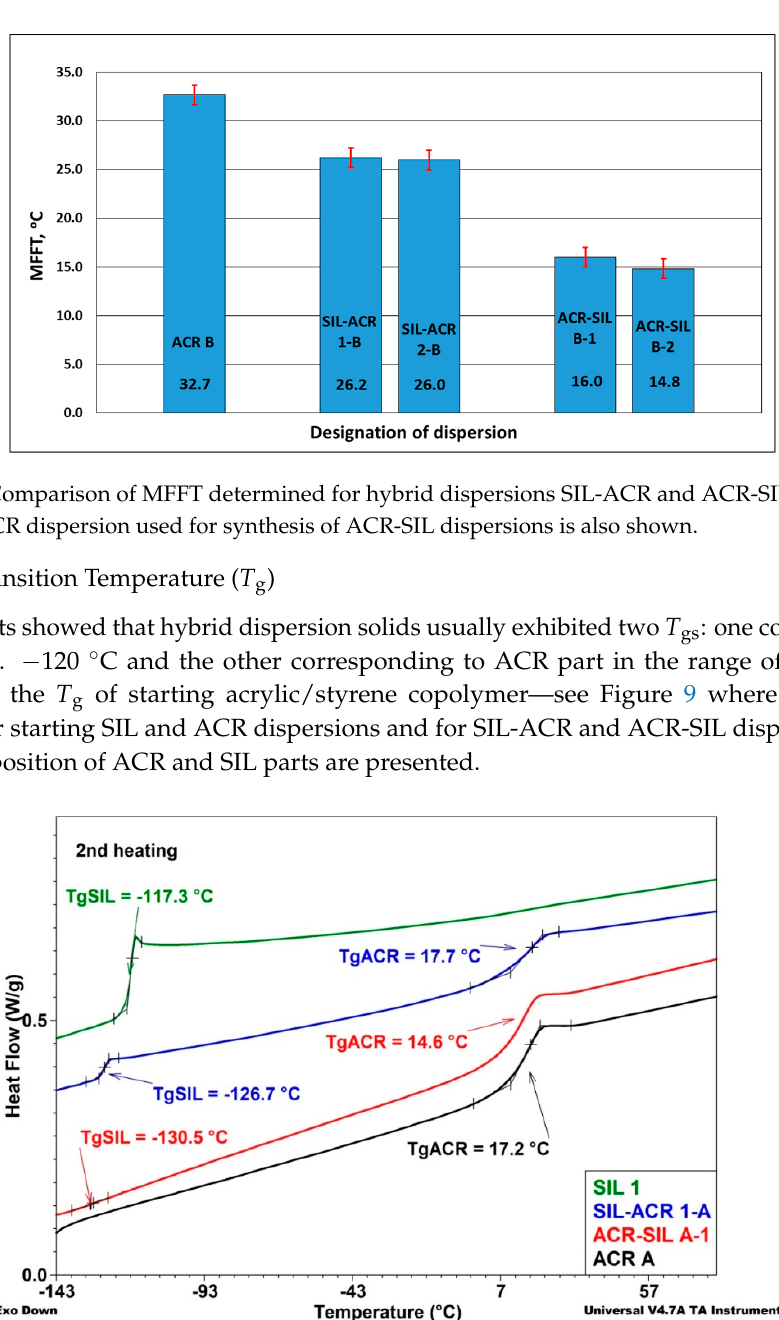
( c ) Figure 7. Structure of hybrid dispersion particles settled on the micromesh net as determined by transmission electron microscopy (TEM): ( a ) SIL-ACR dispersion, higher magnification, ( b ) SIL-ACR dispersion, lower magnification, ( c ) ACR-SIL dispersion, higher magnification. Lighter shade represents silicone resin and darker shade–acrylic/styrene copolymer. Lack of formation of core-shell ACR-SIL hybrid particles in the course of polymerization of silicone monomers in acrylic/styrene copolymer dispersion could have been expected since it was clear from the review of available literature on that subject [11] that only if special approaches were applied to synthesis (e.g., functionalization of acrylic particle surface with silane and hydrolysis of alkoxysilane groups prior to polymerization [22]) the particles with acrylic polymer core and silicone shell could be obtained. 3.1.3. Minimum Film-Forming Temperature (MFFT)